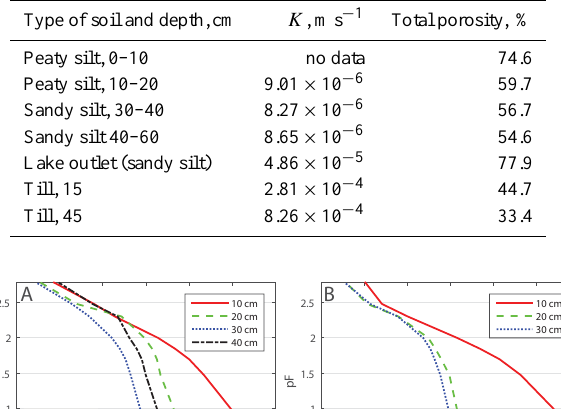
Table 7. Saturated hydraulic conductivity calculated from grain size analysis and total porosity from undisturbed soil samples.